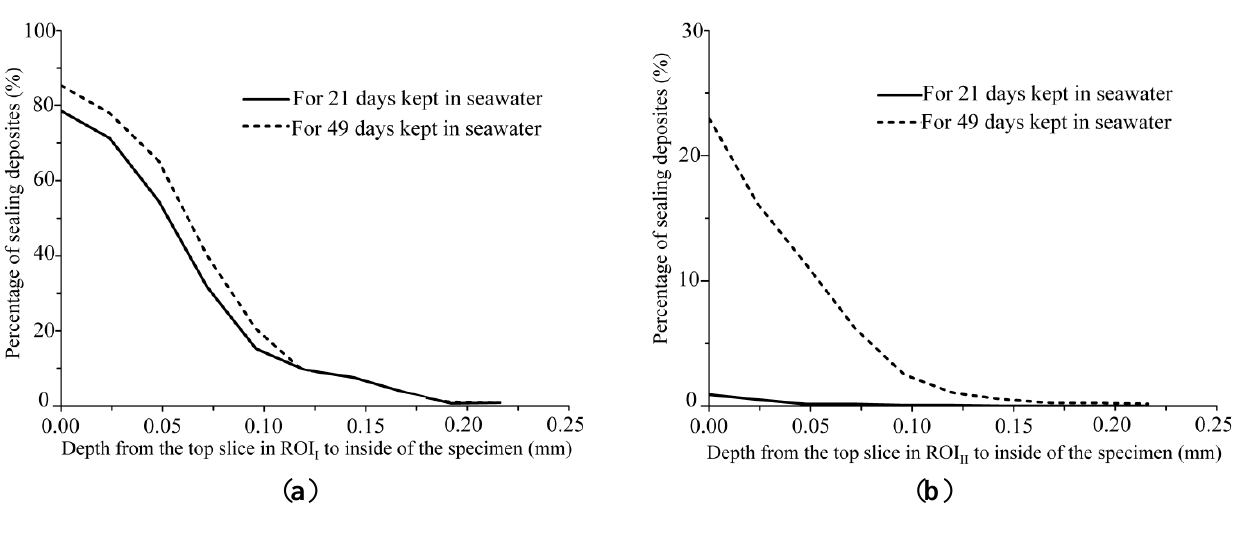
Figure 9. Relationship between percentage and position of sealing deposits in specimen kept in seawater for 21 and 49 days for ( a ) ROI